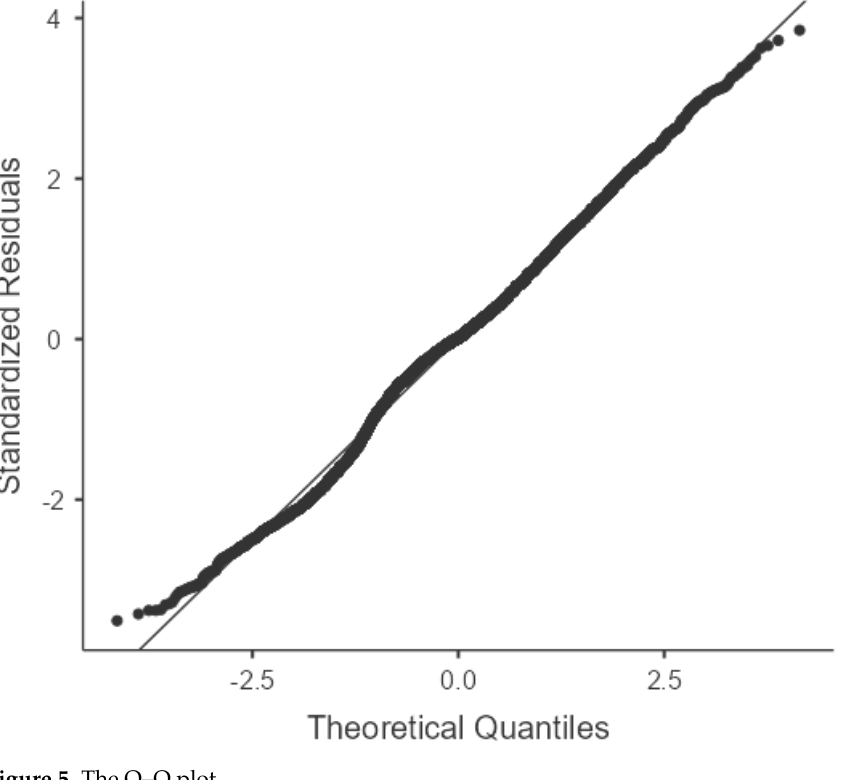
Figure 5. The Q–Q